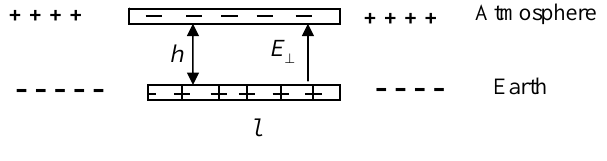
Figure 1. Analog contour Fig. 1. Analog